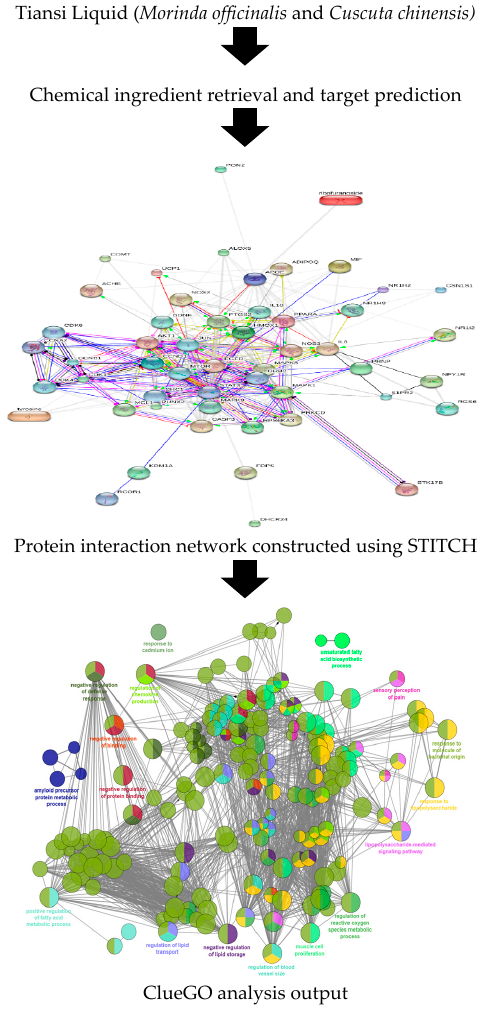
Figure 2. Flow chart presentation of systematic procedure utilized in this study.